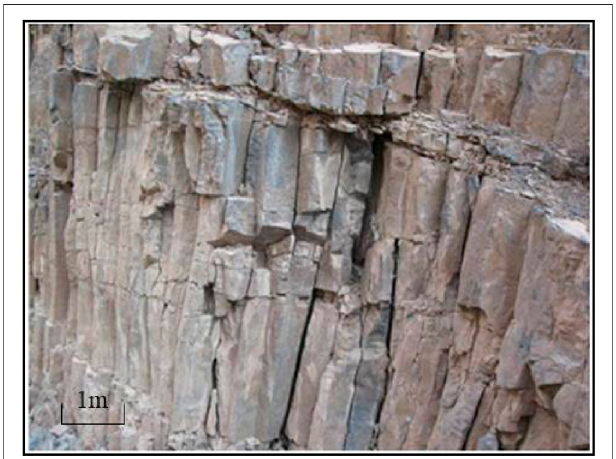
FIGURE 1 | Anisotropy characteristics of columnar joints in dam site area.